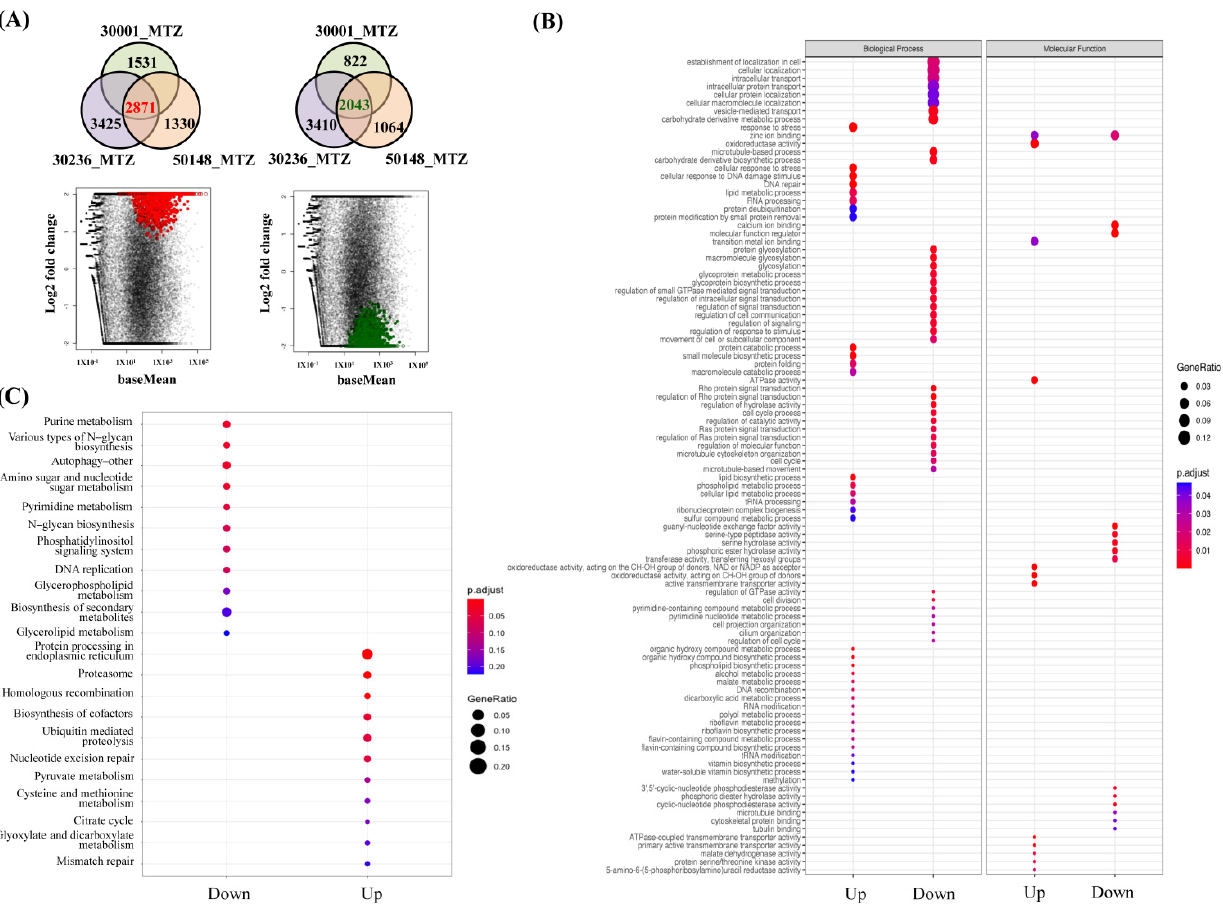
Figure 6. Functional enrichment analysis of DEGs in MTZ-S transcriptomes treated with MTZ compared with those of the untreated MTZ-S group. ( A ) Venn diagram showing the number of DEGs shared by three MTZ-S T. vaginalis strains treated with MTZ (Tv-30001_MTZ, Tv-30236_MTZ, and Tv50148_MTZ), whose expressions are upregulated (2871 genes) and downregulated (2043 genes) in comparison with the untreated MTZ-S parasites. MA plots represent the expression levels (baseMean) and expression changes (log2 fold change in normalized counts values) in the corresponding DEGs. ( B ) GO enrichment analysis of DEGs shared by three MTZ-S strains treated with MTZ compared with the untreated MTZ-S parasites. A significant upregulation and downregulation was observed in GO categories that include biological process and molecular function. ( C ) KEGG enrichment analysis of the DEGs shared by three MTZ-S strains treated with MTZ compared with the untreated MTZ-S parasites. A significant upregulation and downregulation were observed based on KEGG pathways. Dot size represents the ratio of genes in each category, and color indicates the adjusted p -value.